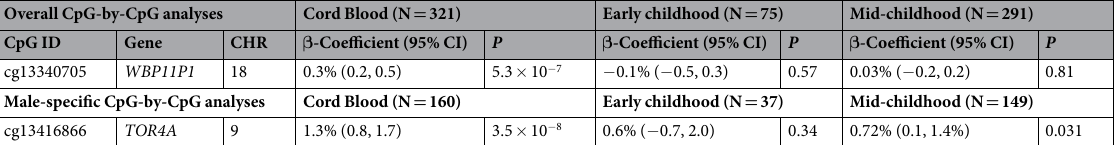
Table 3. Adjusted percent change in blood DNA methylation per doubling in prenatal mercury exposure for individual loci found to be differentially methylated at birth (cord blood) in the CpG-by-CpG analysis and persistence of associations during early and mid-childhood.